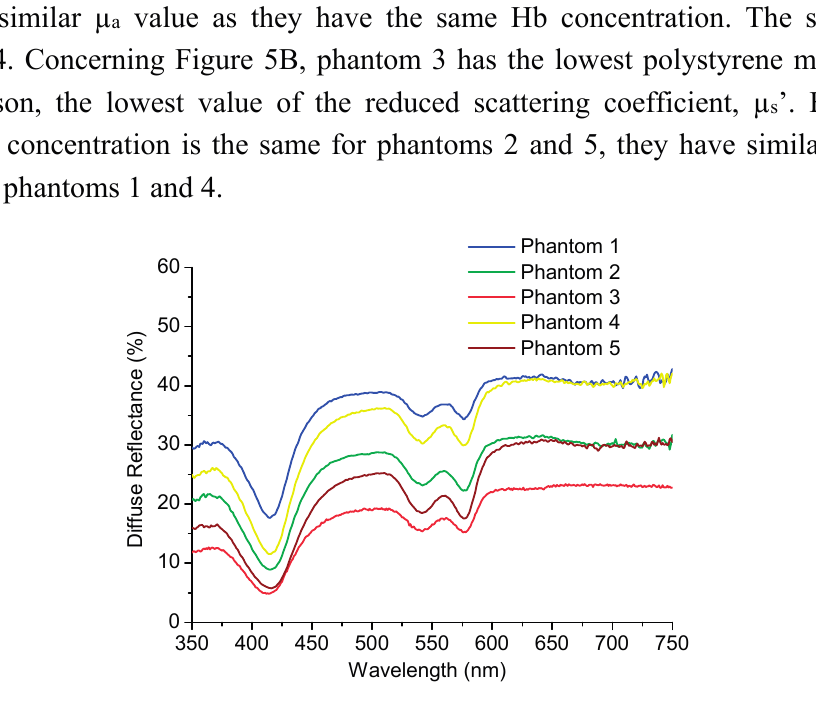
Figure 4. Experimental diffuse reflectance signal for all the test phantoms.